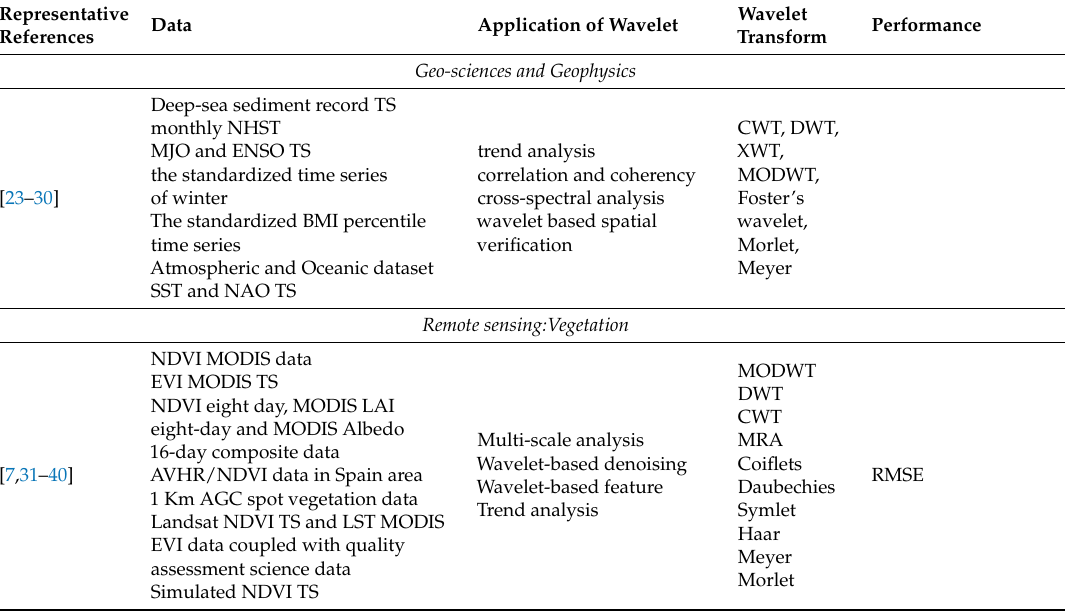
Table 1. Details of the surveyed papers, including year of publication, authors, the field, the data, the selected WT, the application of WT and the performance. MSE: Mean Squared Error, MRE: Mean Relative Error, RE: Relative Error, RMSE: Root Mean Square Error, MAPE: Mean Absolute Percentage